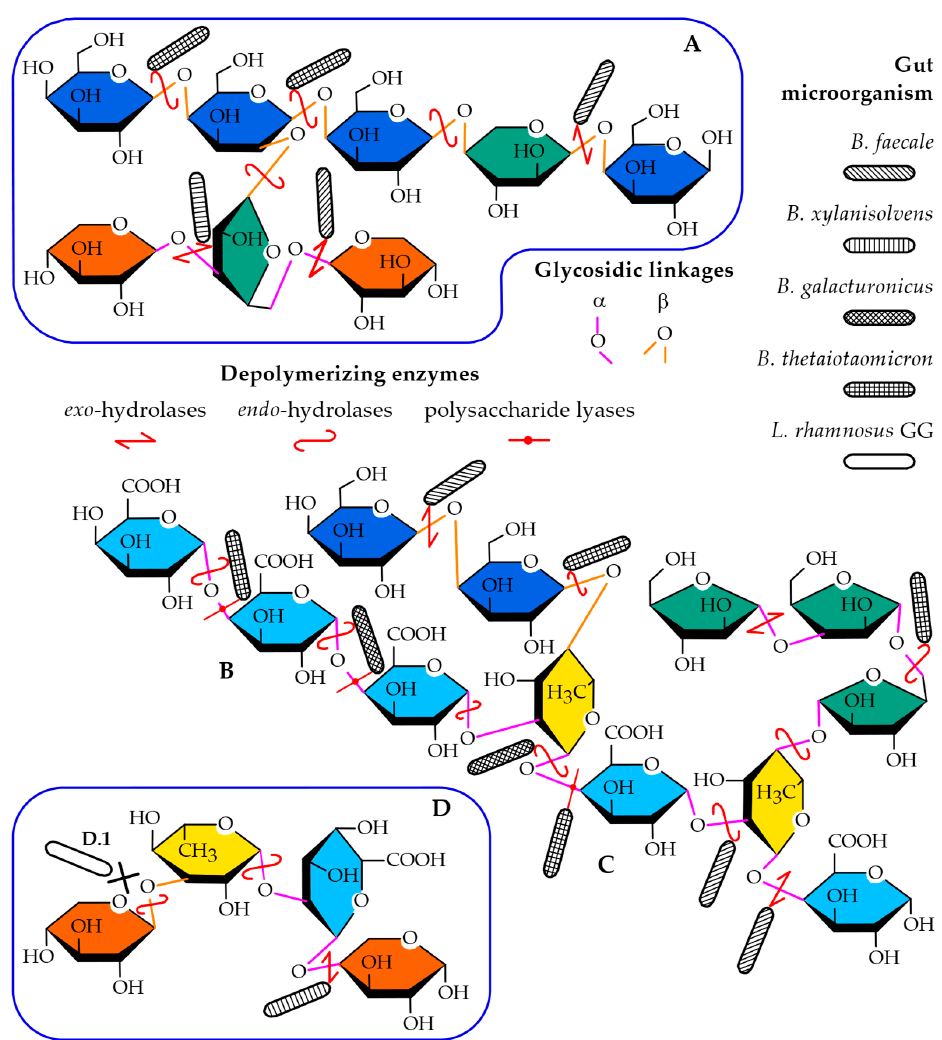
Figure 1. Common saccharide motifs exemplifying some of the monosaccharides and glycosidic linkages present in the mucilage of dicots. ( A ) Branched galactan (including β -Gal p -(1,4)-, β -Gal p - (1,2,4)-, β -Ara p -(1,4)-, α -Ara f -(1,3,5)-, and β -Xyl p- (t)). ( B ) Homogalacturonan (including α -GalA p - (1,4)-). ( C ) Rhamnogalacturonan I (including α -Rha p -(1,2,5)-, β -Gal p -(t), α -Ara f -(1,5)-, α -Ara f -(t), and α -GalA p- (t)). ( D ) Branches of xylan (including β -Xyl p- (1,3)-, α -Rha p -(1,3)-, α -GalA p -(1,2)-, and α -Xyl p- (t)). (D.1) representation of a linkage sterically unavailable for a microorganism. Galactose, blue; galacturonic acid, light blue; xylose, orange; rhamnose, yellow and arabinose, green. α -linkages are represented in pink, while β -linkages are colored orange. Depolymerizing enzymes are drawn as red lines: endo -acting hydrolases as rounded double arrows, exo -acting hydrolases as double arrows, and lyases as lines with a dot in the middle. The different bacteria ( B. faecales , rod with diagonal fill, B. xylanisolvens , rod with vertical fill, B. thetaiotaomicron , rod with square fill, B. galacturonicus rod with crosshatch fill, L. rhamnosus GG, no fill) are shown attached to the red hydrolases in potential sites of depolymerization, based on their reported hydrolytic toolkit.